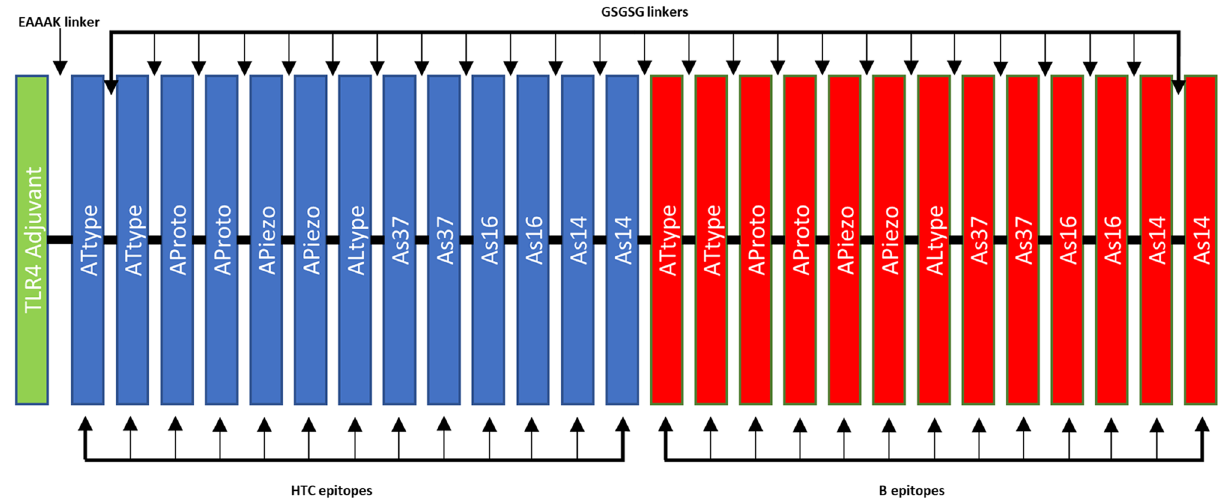
Figure 2. Schematic representation of the final multi epitope vaccine. The sequence contains 579 amino acids with the RS09 TLR4 adjuvant (green) linked at the N-terminal through an EAAAK linker. Both Helper T-cell (blue) epitopes and B-cell epitopes (red) are linked with a GSGSG